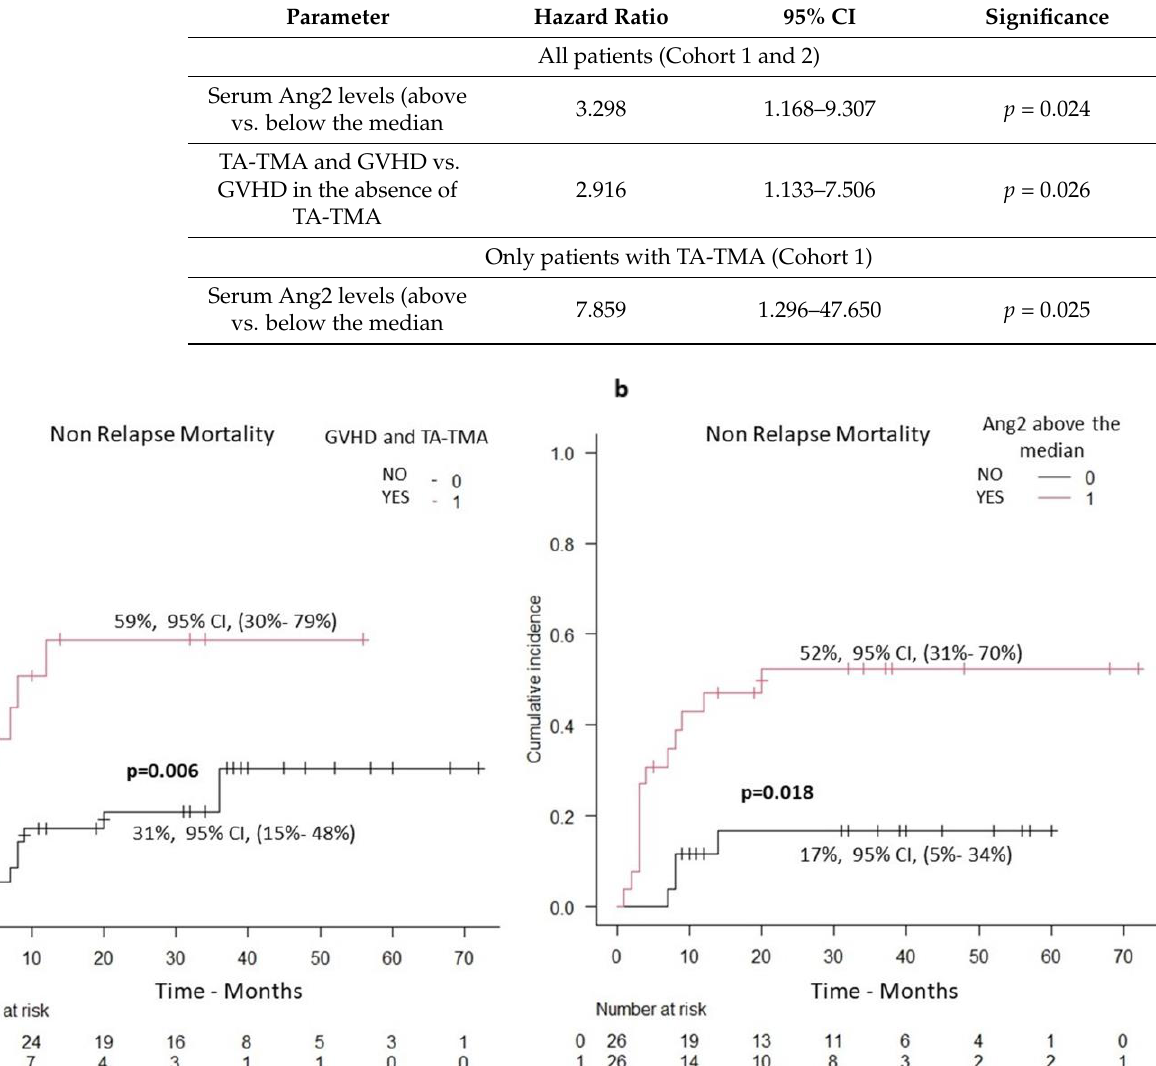
Table 2. Multivariate analysis for Non-Relapse Mortality.